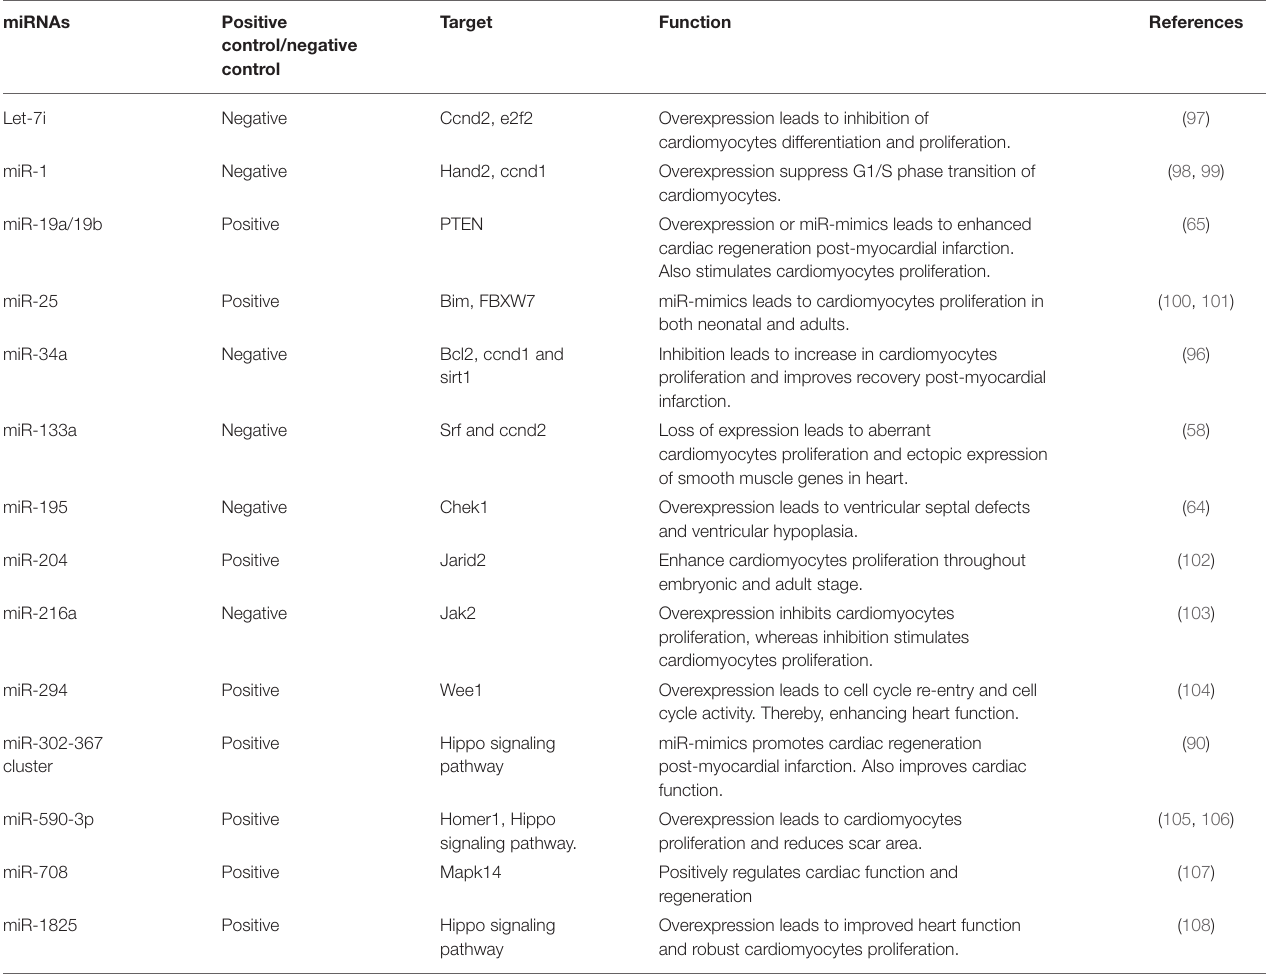
TABLE 2 | miRNAs that controls cardiomyocytes proliferation and heart regeneration.